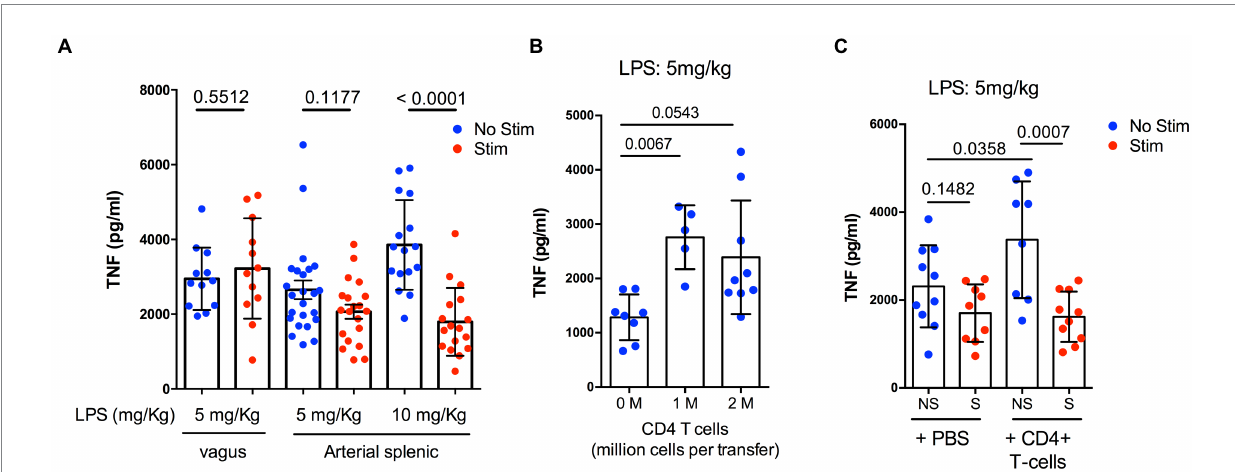
FIGURE 3 Cholinergic anti-inflammatory pathway in nude (FoxN1 − / − ) mice. Nude mice were implanted onto the vagus (A) or arterial splenic (A–C) nerve with a micro-cuff electrode 1 week before electrostimulation was applied. (C) One, two or five millions CD4 + T-cell (1 M, 2 M, 5 M) or PBS (0 M) were transferred on day − 1 relative to electrostimulation. One week after surgery, LPS was injected and electrical stimulation was applied or not (650 μ A, 10 Hz, 2 min duration, − 20, 0 and +10 relative to LPS injection) in freely moving animals. Data show serum TNF levels in individual mice ±SEM of 2–5 experiments ( n ≥ 5/group) in non-electrically stimulated (NS, blue) and electrically stimulated (S, red) mice. (A,C) Mann–Whitney and (B) Kruskal–Wallis followed by Dunn’s post-hoc test were